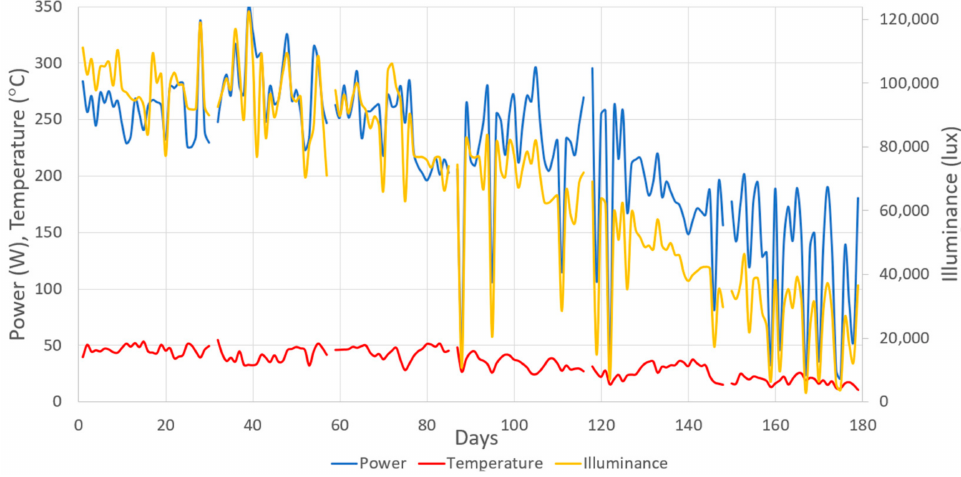
Figure 10. A graph of the power and intensity of solar radiation recorded between June and Novem- ber